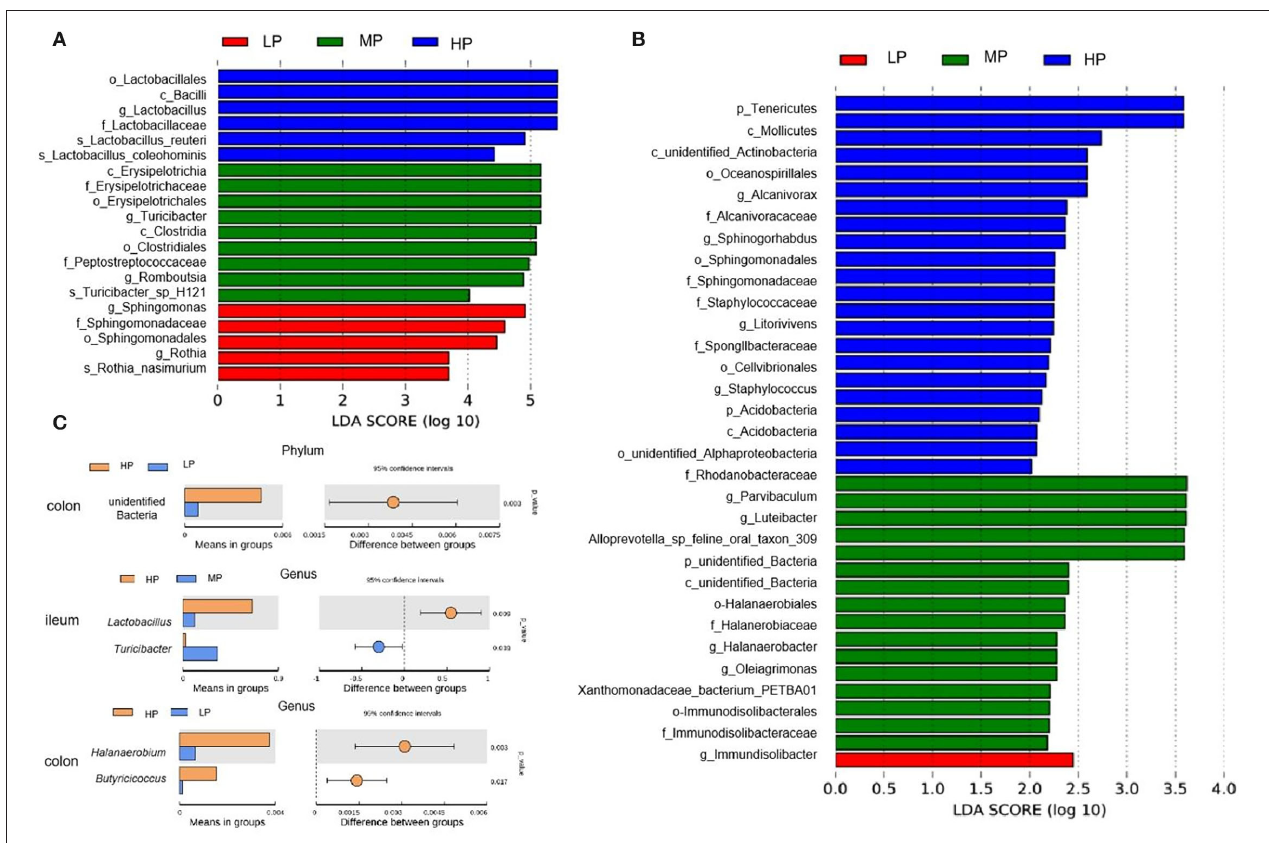
FIGURE 6 | Linear discriminant analysis (LDA) effect size (LEfSe) and t -test analysis ( P < 0.05, LDA > 2) of gut microbiota. LEfSe analysis for ileal (A) and colonic (B) digesta samples. (C) T -test analysis of gut microbiota. HP, high protein (16% crude protein); MP, medium protein (12% crude protein); LP, low protein (10% crude